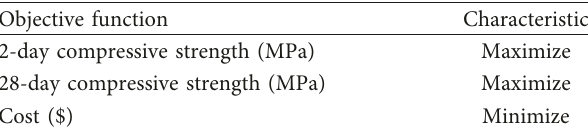
Figure 4: The effect of flay ash content and additive dosage on the cost (in Turkey). Table 6: Optimization parameters used in cement production.